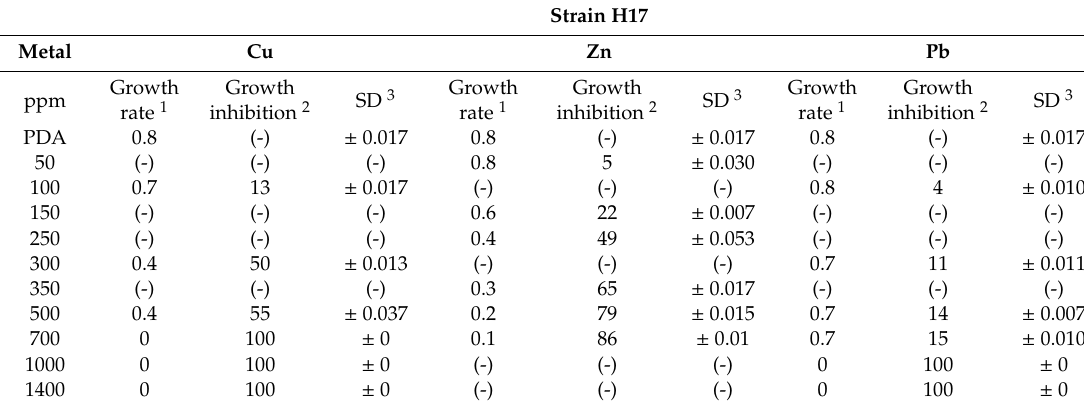
Table 1. Growth and growth percentage inhibition values for strain H17 cultivated in di ff erent metal concentrations.